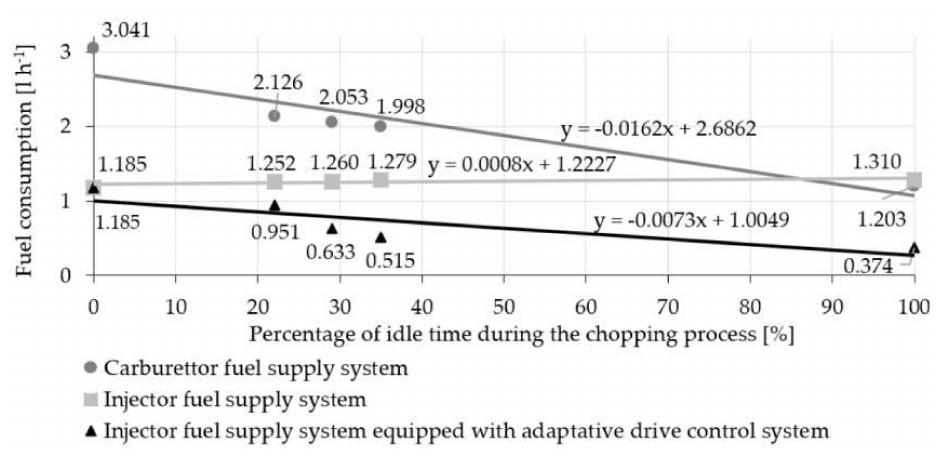
Figure 4. Fuel consumption under selected operating conditions: Transient exploitation conditions